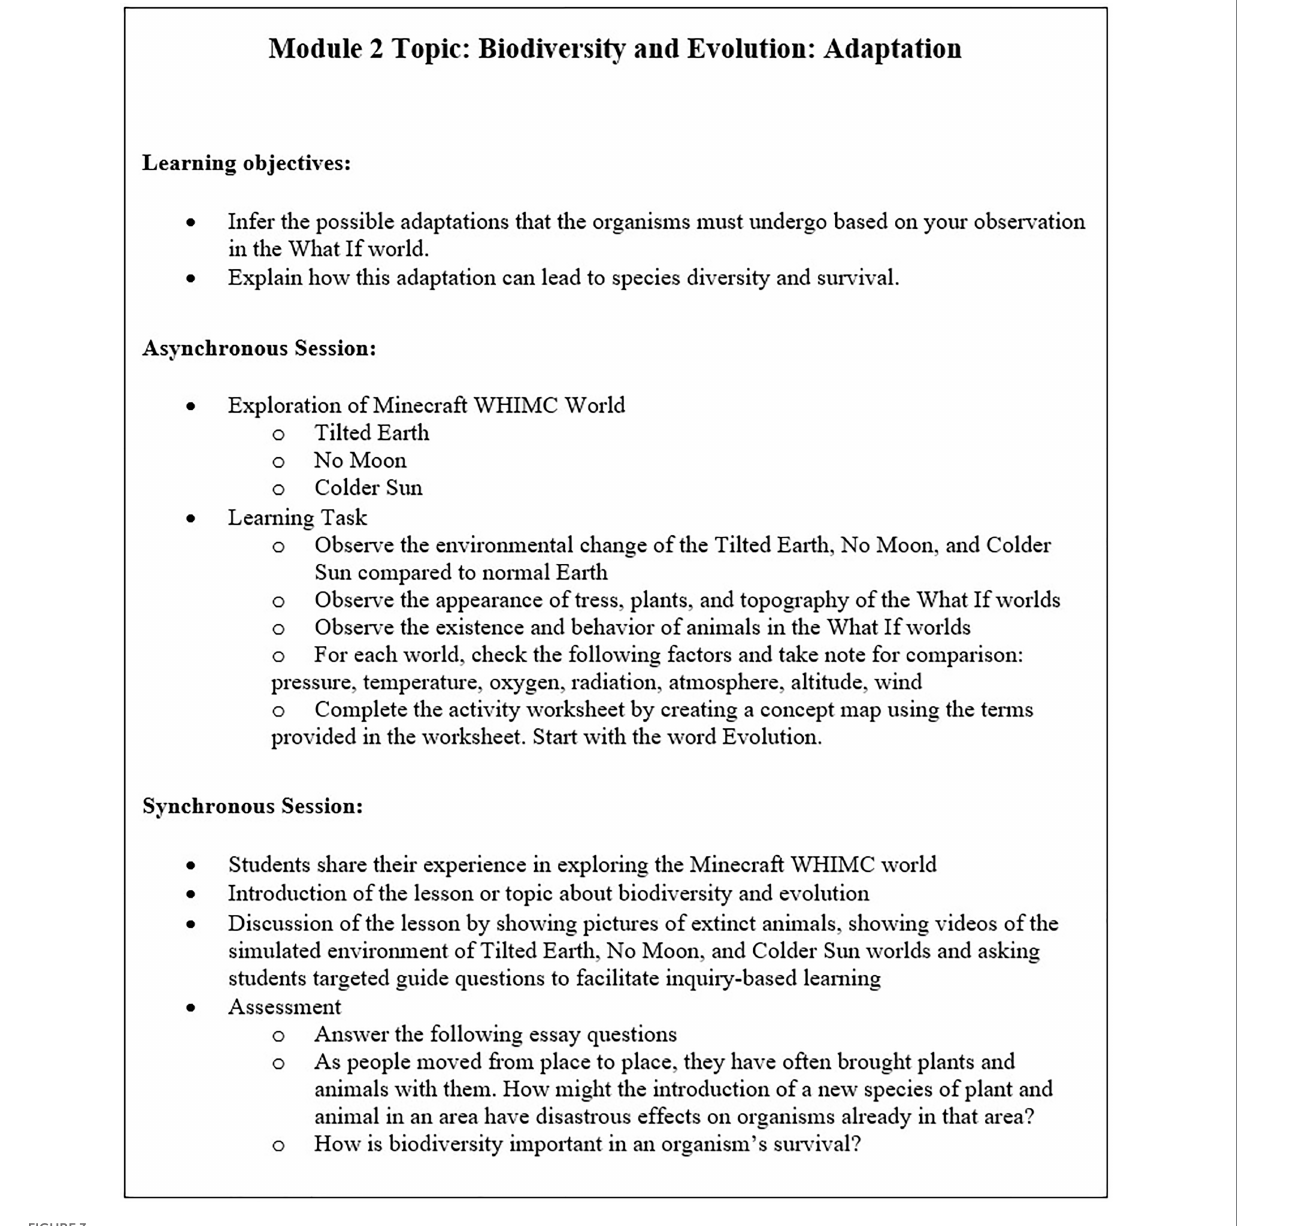
FIGURE 3 Lesson excerpt of module